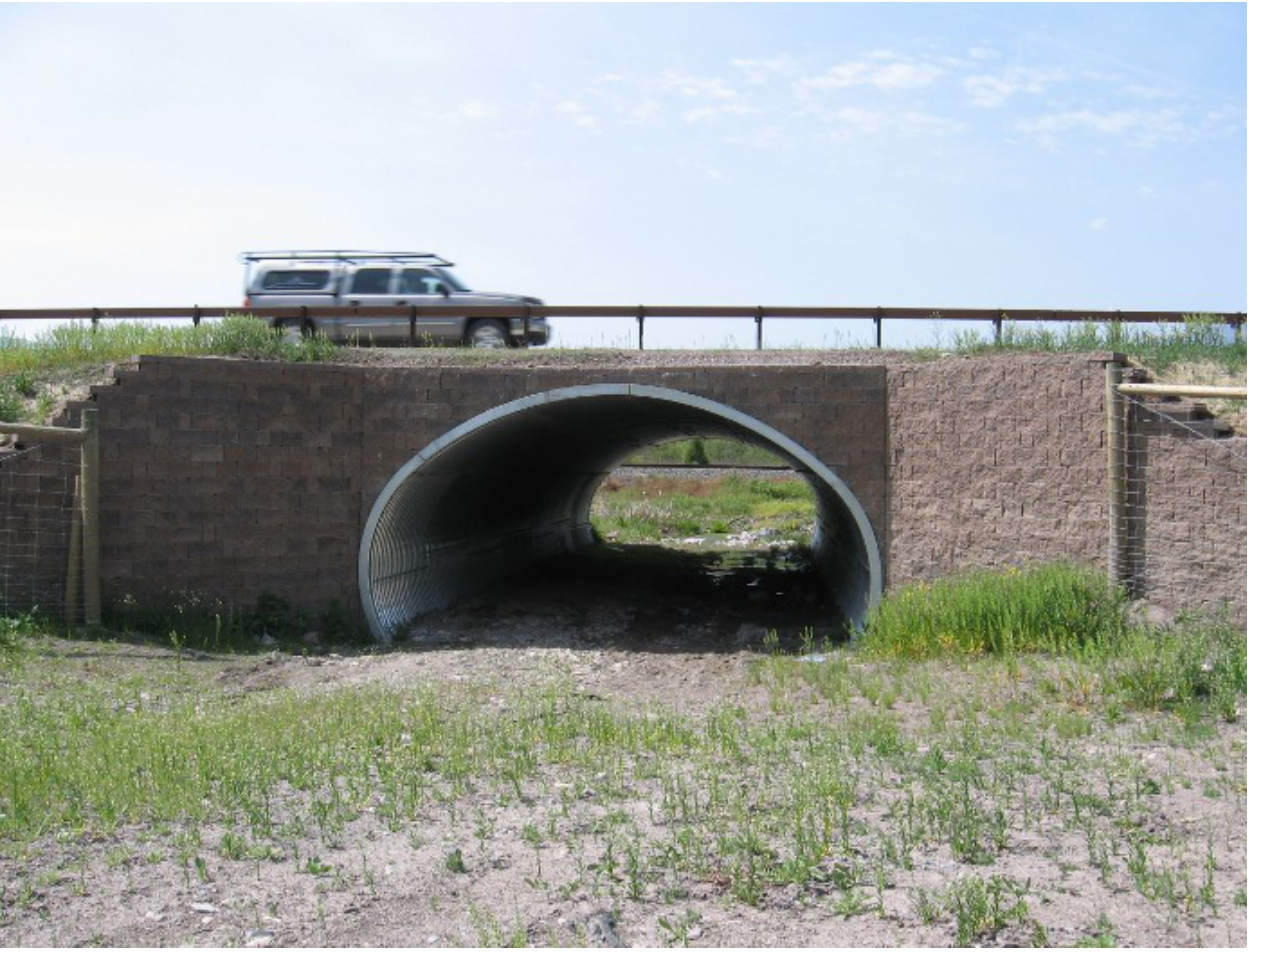
Fig. 2. A large-mammal underpass (7–8 m (23–26.2 ft) wide, 4–5 m (13.1–16.4 ft) high) along U.S. Highway 93 on the Flathead Reservation, Montana, USA (copyright: Marcel